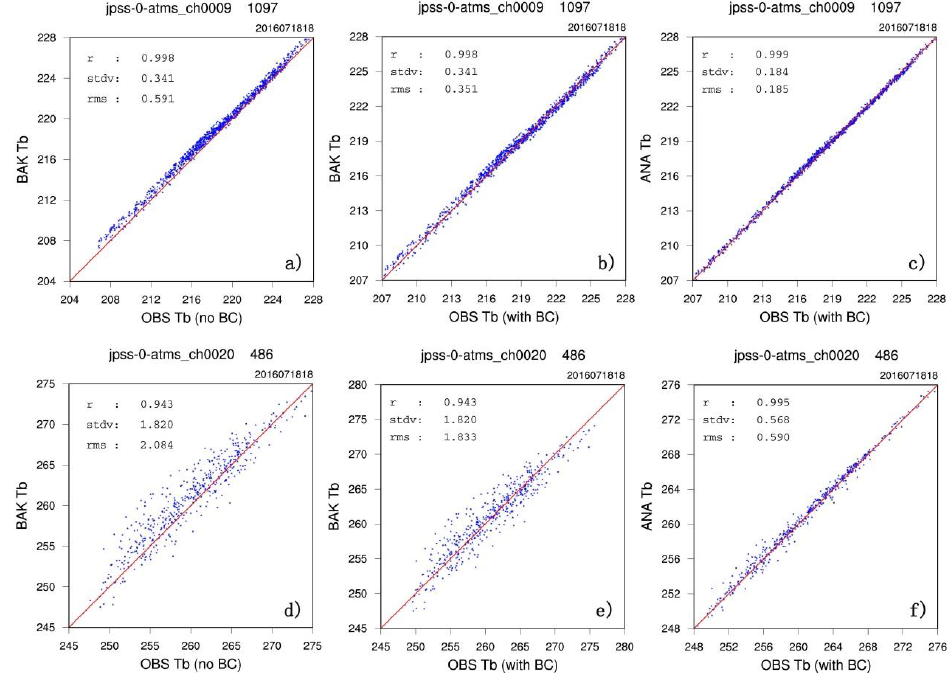
Figure 6. The scatter plots of brightness temperatures (K) simulated by CRTM against observations from ATMS channels 9 and 20 at 1800 UTC 18 July 2016. ( a , d ) and ( b , e ): Background (BAK) versus observations before (no BC) and after (with BC) bias correction, respectively. ( c , f ): Analysis (ANA) versus observations.